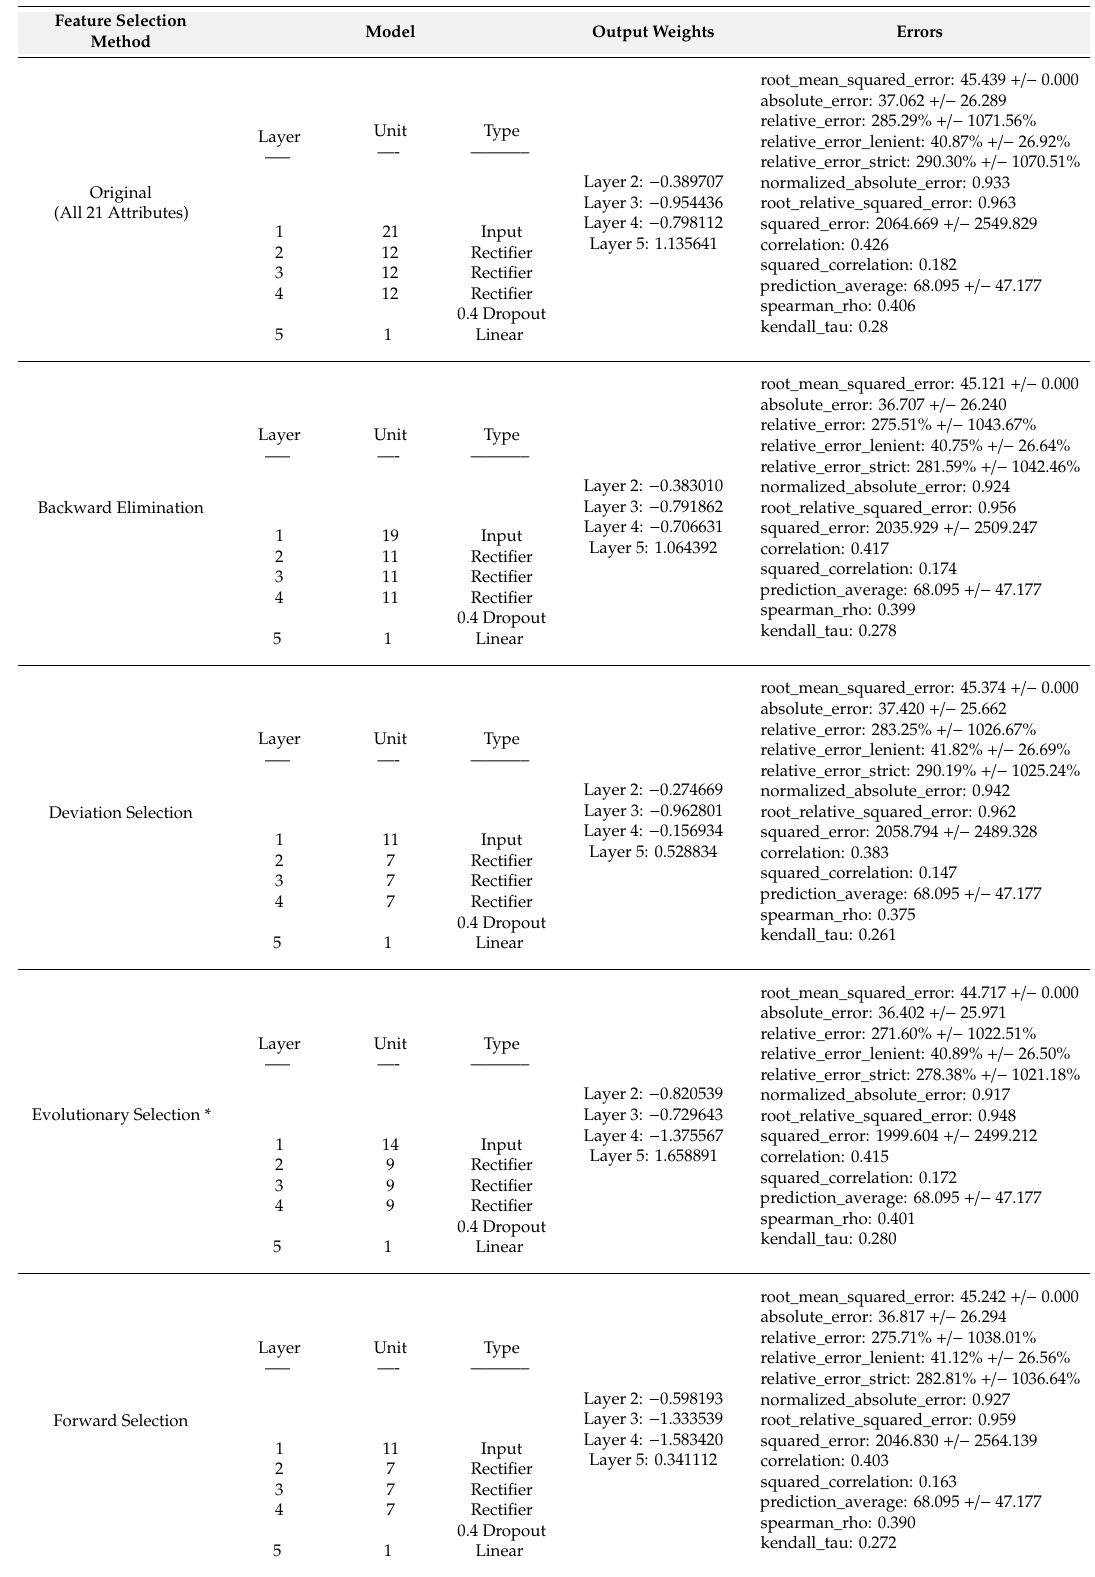
Table 5. The best DNN Models for FD002 test